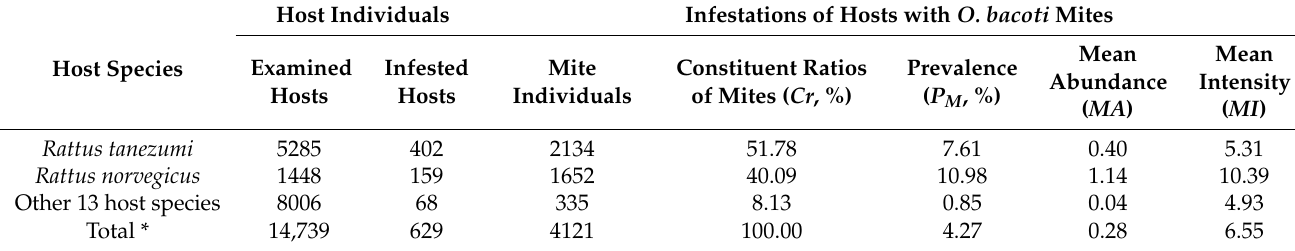
Table 1. Infestations of two dominant rat hosts ( Rattus tanezumi and R. norvegicus ) with tropical rat mites ( Ornithonyssus bacoti ) in Yunnan Province, Southwest China